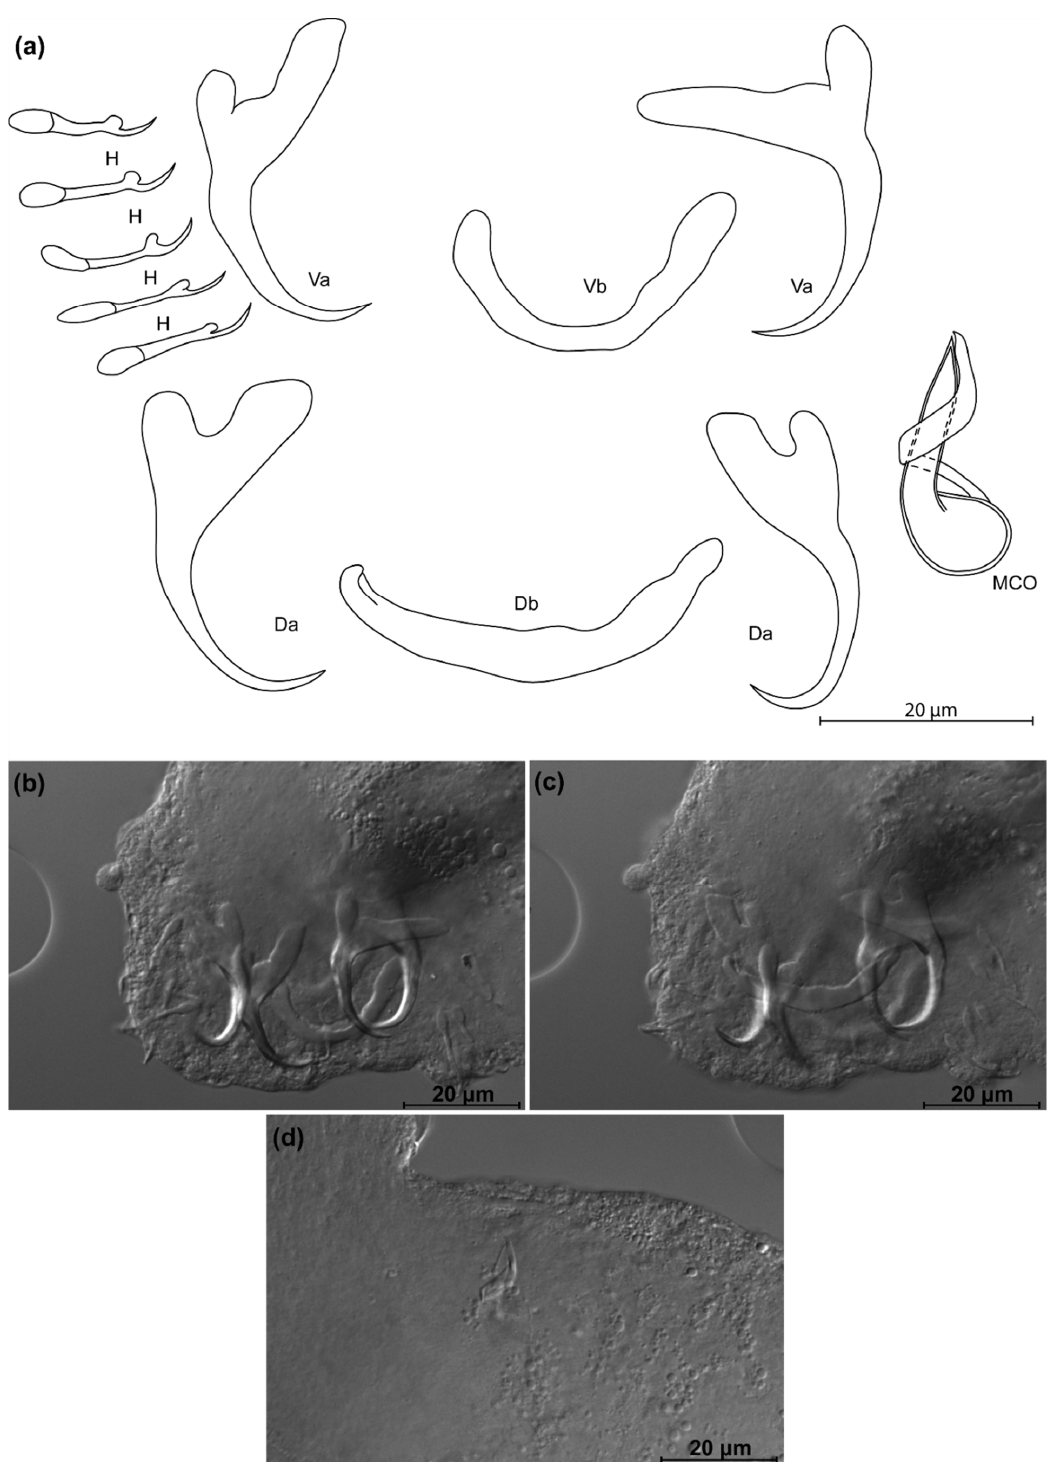
Figure 16. Kapentagyrus boegeri n. sp. (ex Microthrissa congica ). ( a ) Drawings of sclerotized structures, Va-ventral anchors, Db-dorsal bar, Vb-ventral bar, H-hooks (no pairs assigned). ( b ) Micrograph of ventral anchors and ventral bar. ( c ) Micrograph of dorsal anchors and dorsal bar. ( d ) Micrograph of MCO.